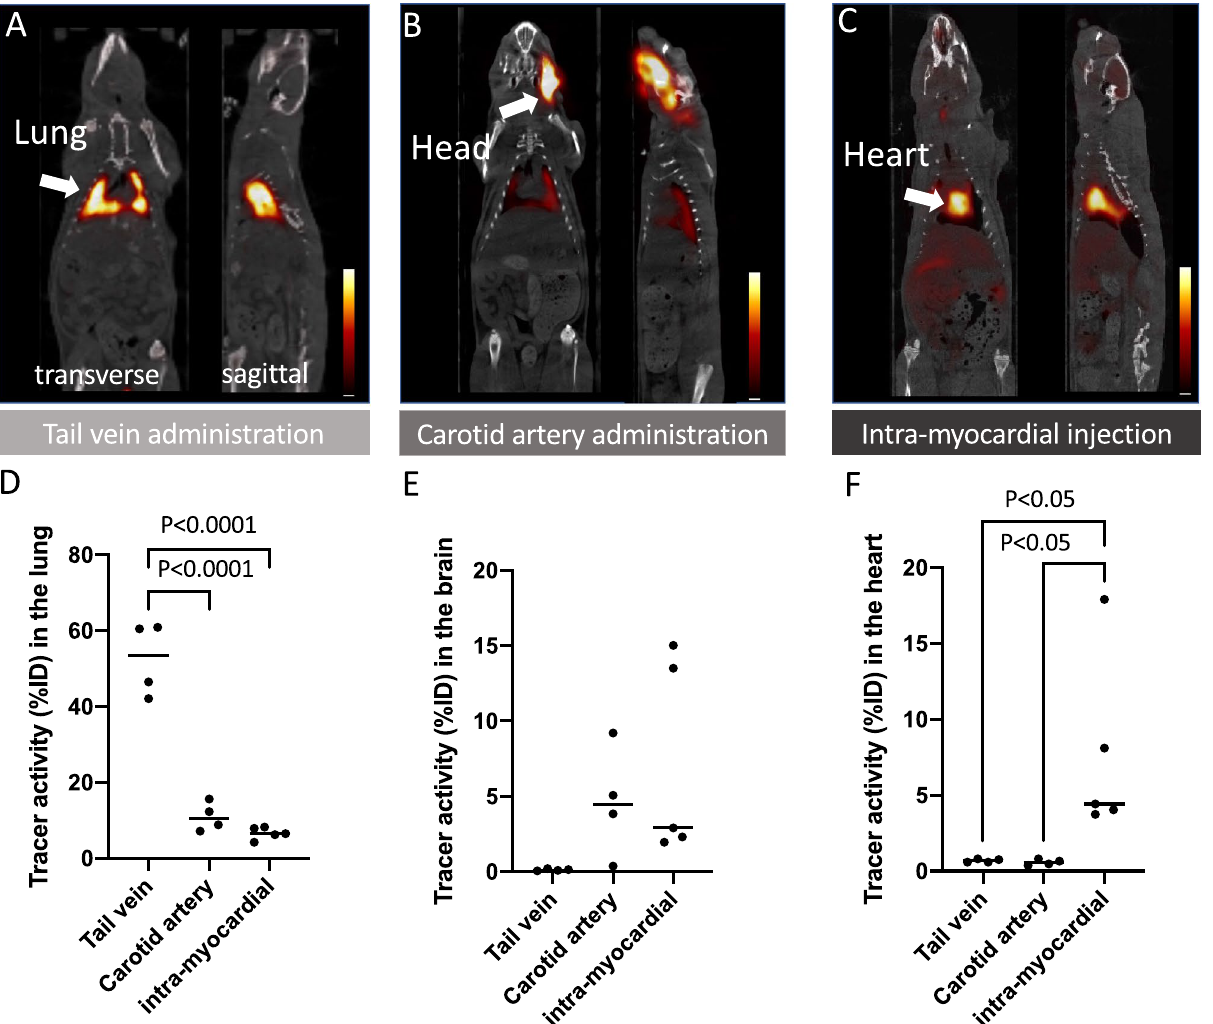
Figure 4. Representative PET images of rats with cell administration via tail vein ( A ), common carotid artery ( B ), and intra-myocardial injection ( C ). High radiotracer activity is seen in the lung, head, and heart in the group of animals with tail vein administration, carotid artery injection, and intra-myocardial injection, respectively. Results of tissue counting of the lung ( D ), brain ( E ), and heart ( F ) with different routes of cell administration are shown in the